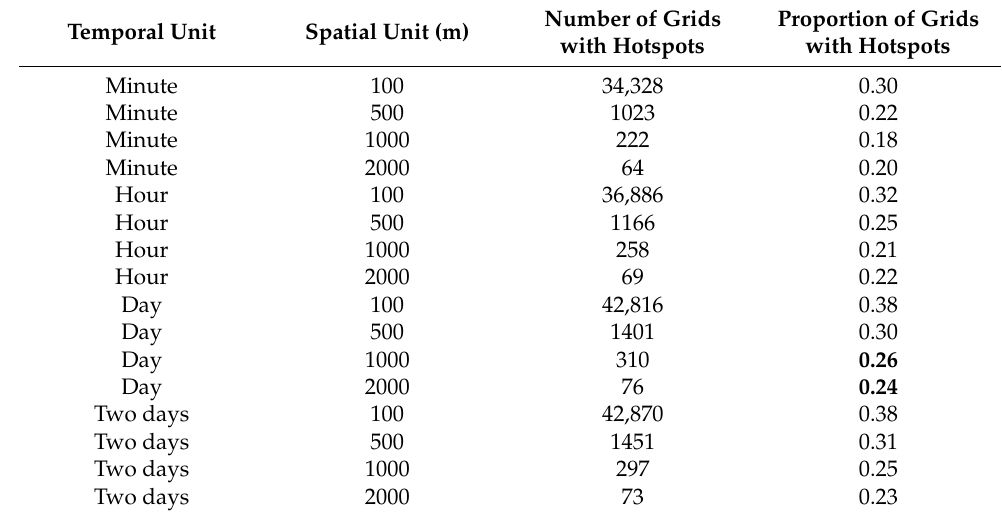
Figure 7. Distributions of urban hotspots for two significant spatiotemporal units: ( a ) day/1000 m and ( b ) day/2000 m. Table 5. Proportion of hotspots for different spatiotemporal